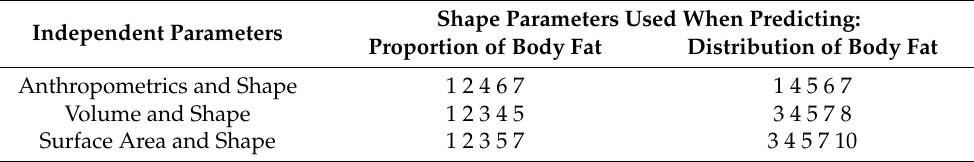
Table 2. The shape parameters used in each linear regression model. Each number corresponds to a specific shape parameter. For example, the regression model predicting body fat proportion with anthropometric parameters used shape parameters PC1, PC2, PC4, PC6 and PC7. Shape Parameters Used When Predicting: Independent Parameters Proportion of Body Fat Distribution of Body Fat Anthropometrics and Shape 1 2 4 6 7 1 4 5 6 7 Volume and Shape Surface Area and Shape